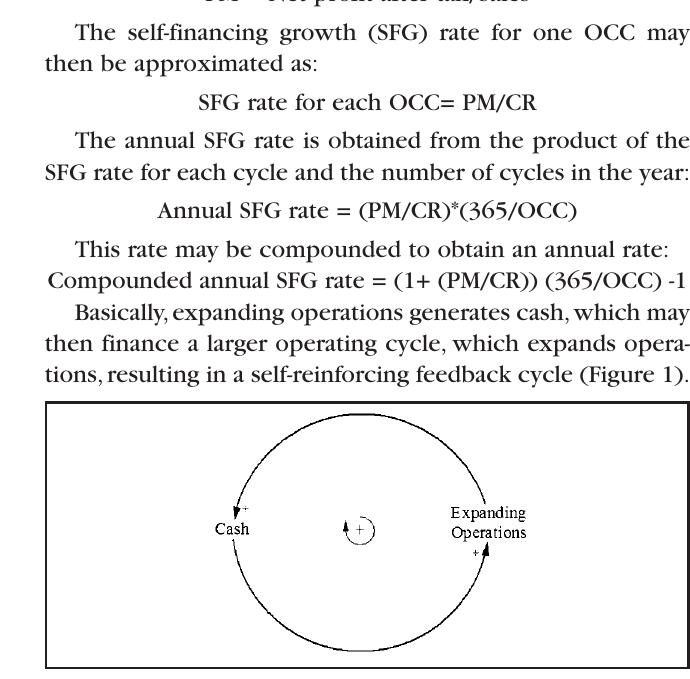
Figure 1. Self-reinforcing Feedback